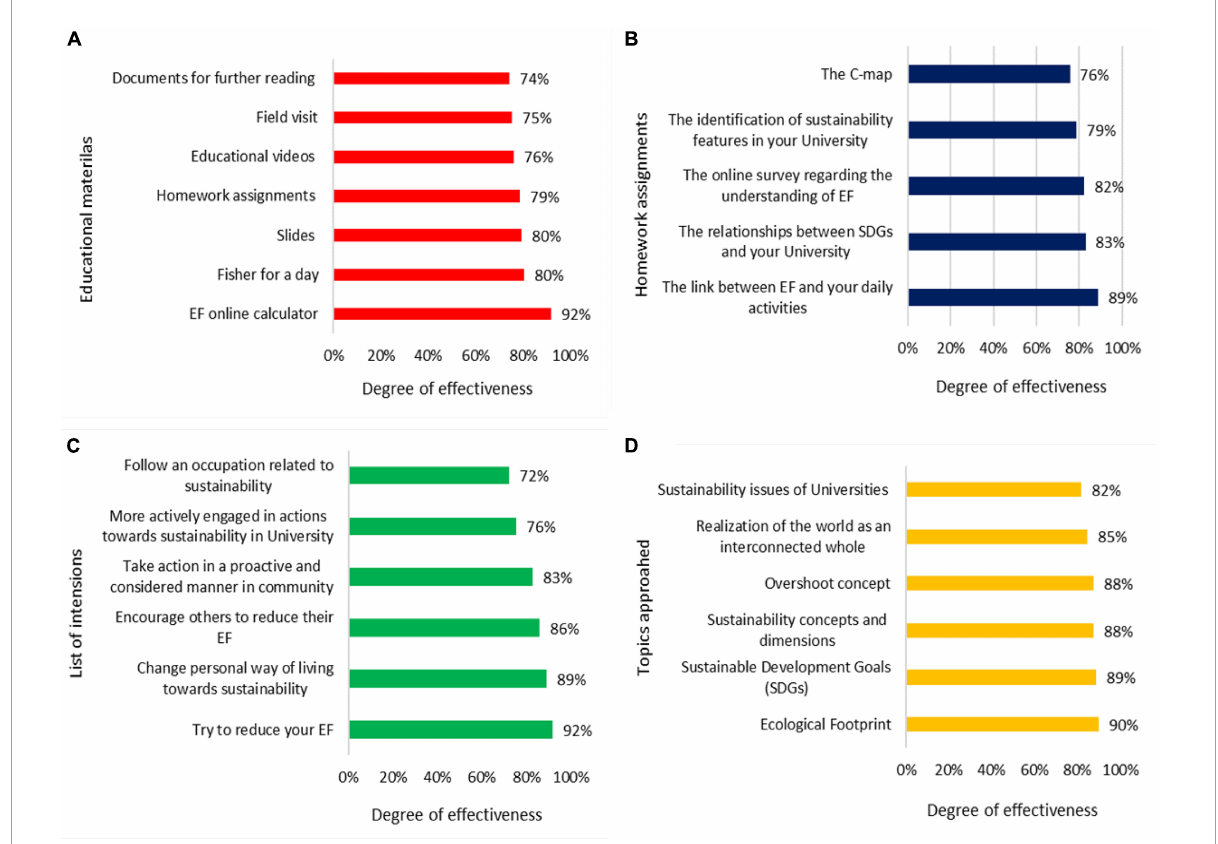
FIGURE5 Overall students’ satisfaction (A) and feedback (B) on the EUSTEPs Module. Students’ feedback is broken down by Module features and by University (expressed in percentage of the scoring scale).